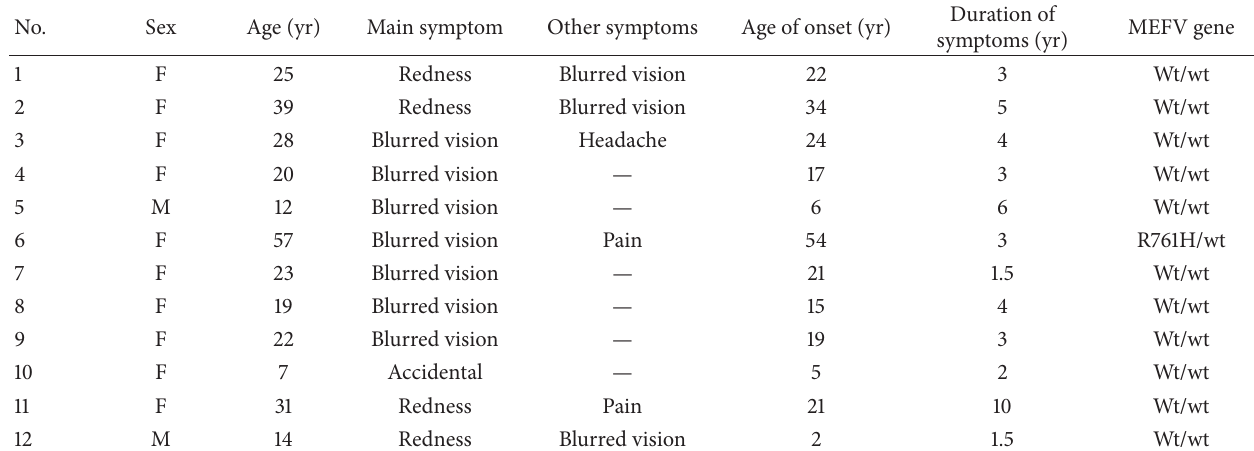
Table 1: Patients’